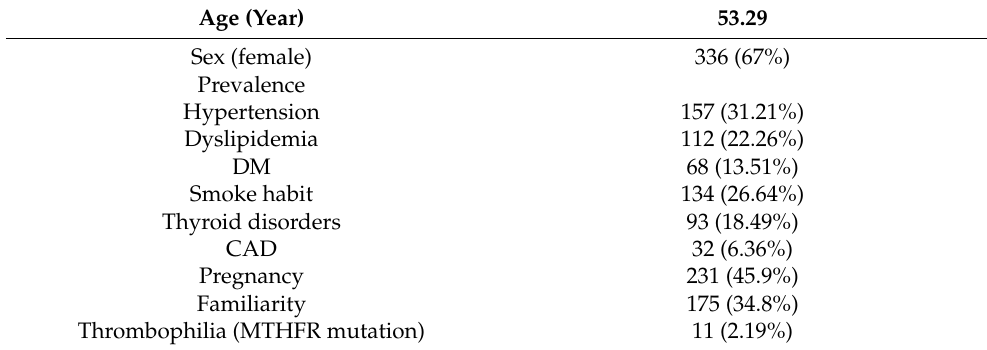
Table 1. Preoperative patients’ characteristics.